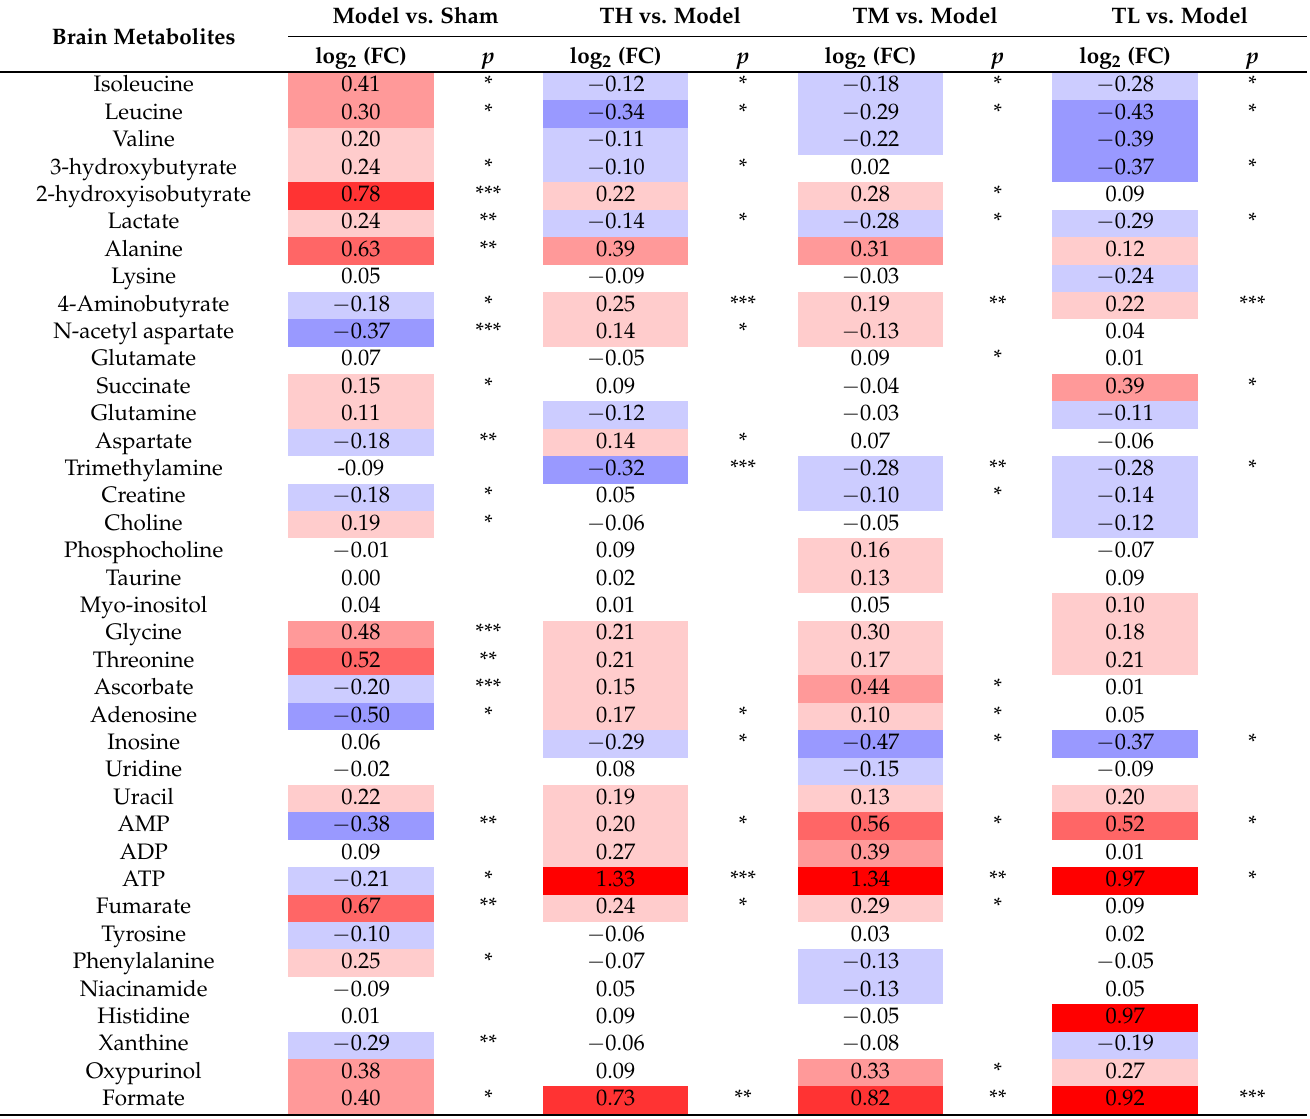
Table 1. Fold changes of brain metabolites between groups and the associated p -Values. Model vs. Sham TH vs. Model TM vs. Brain Metabolites